Question: Express in one sentence what the figure is showing.
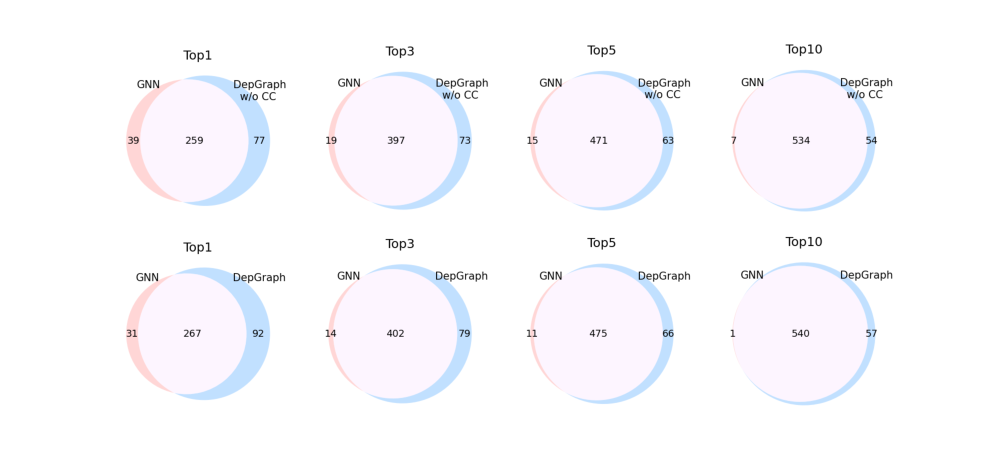
Answer: Overlaps between the faults that DepGraph and GNN (i.e., Grace) locate in Top-1, 3, 5 and 10. The overlapping regions contain a number of faults that have the same ranking in both of the techniques. The non-overlapped regions contain faults that were uniquely located by each technique. We consider both DepGraph, and, DepGraph w/o CC (Code Change).